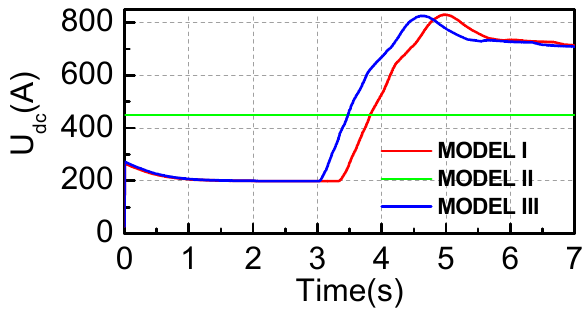
Figure 10. The current trajectory when torque command is restricted at 90 Nm.